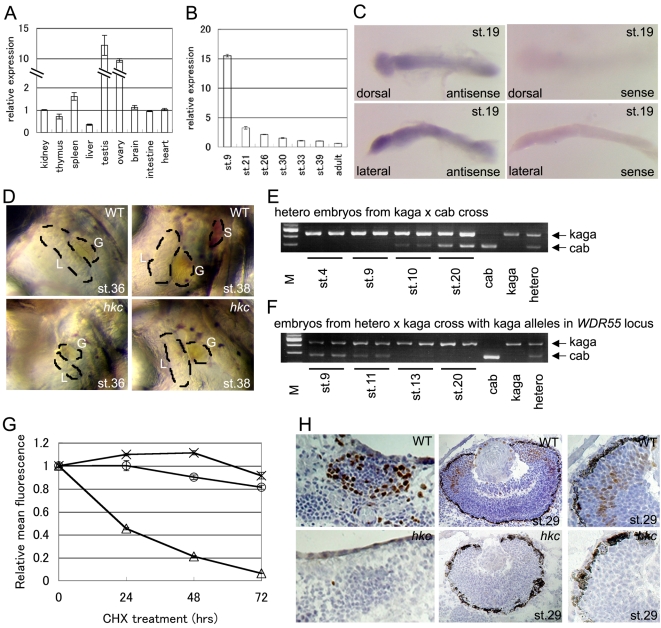
How does hkc mutation result in defects in thymus development?(A) Quantitative RT-PCR analysis of WDR55 in indicated organs of adult WT medaka. The expression in kidney was normalized to 1. Shown are averages and standard errors of three independent measurements. (B) Quantitative RT-PCR analysis of WDR55 in whole bodies of WT medaka at indicated stages. The expression at stage 39 was normalized to 1. Shown are averages and standard errors of four independent measurements. (C) Whole-mount in situ hybridization of WT embryos at stage 19 using WDR55 antisense (left) and sense (right) probes. Dorsal views (top) and lateral views (bottom) are shown. (D) Left ventrolateral views of WT (top) and hkc (bottom) embryos at stage 36 (left) and stage 38 (right). L, liver; G, gall bladder; S, spleen. (E) cDNAs from whole medaka embryos at indicated stages from the mating of kaga females with cab males were amplified for WDR55, followed by cab genotype-specific restriction digestion with BstNI. cDNAs from two individual embryos were analyzed for each stage. cDNAs from adult cab, kaga, and their heterozygotes are shown on the rightmost three lanes. M: size marker. (F) Cab/kaga heterozygous females and kaga males were mated and embryos were selected for individuals carrying kaga-derived WDR55 loci at both alleles. cDNAs from whole medaka embryos at indicated stages were amplified for WDR55, followed by cab genome-specific restriction digestion. (G) Stability of WDR55 proteins. 293T cells were transfected with EGFP (×), EGFP-WDR55WT (○), or pZsProSensor-1 (△) and treated with cycloheximide (CHX) for indicated periods. Fluorescence intensity was measured with a flow cytometer and relative mean fluorescence intensity was plotted. Shown are averages and standard errors of three independent measurements. (H) Detection of BrdU incorporation in WT (top) and hkc (bottom) embryos. Brown, BrdU; blue, hematoxylin. Thymuses of 7-dpf embryos (left) and eyes at stage 29 (middle panels and high-magnification images in right panels) are shown.